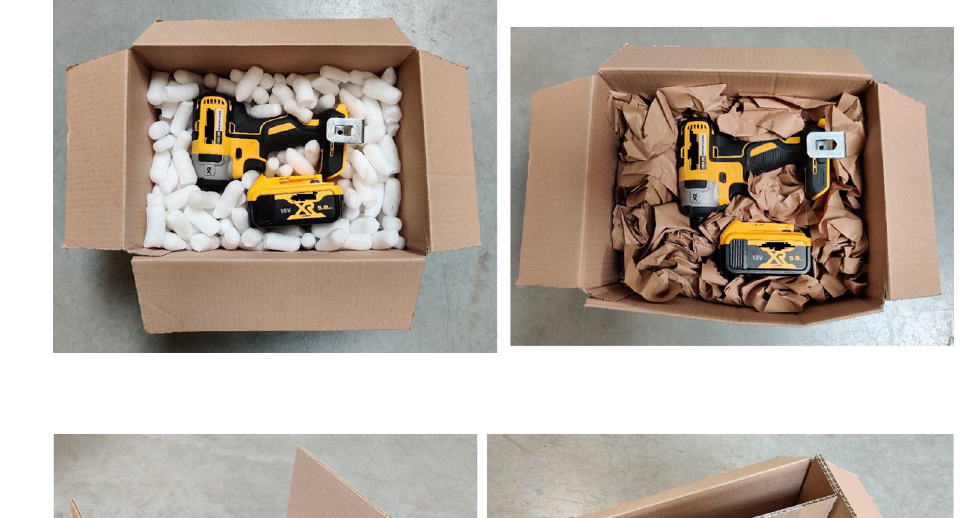
Fig. 1 Examples of void filling in e-commerce packaging